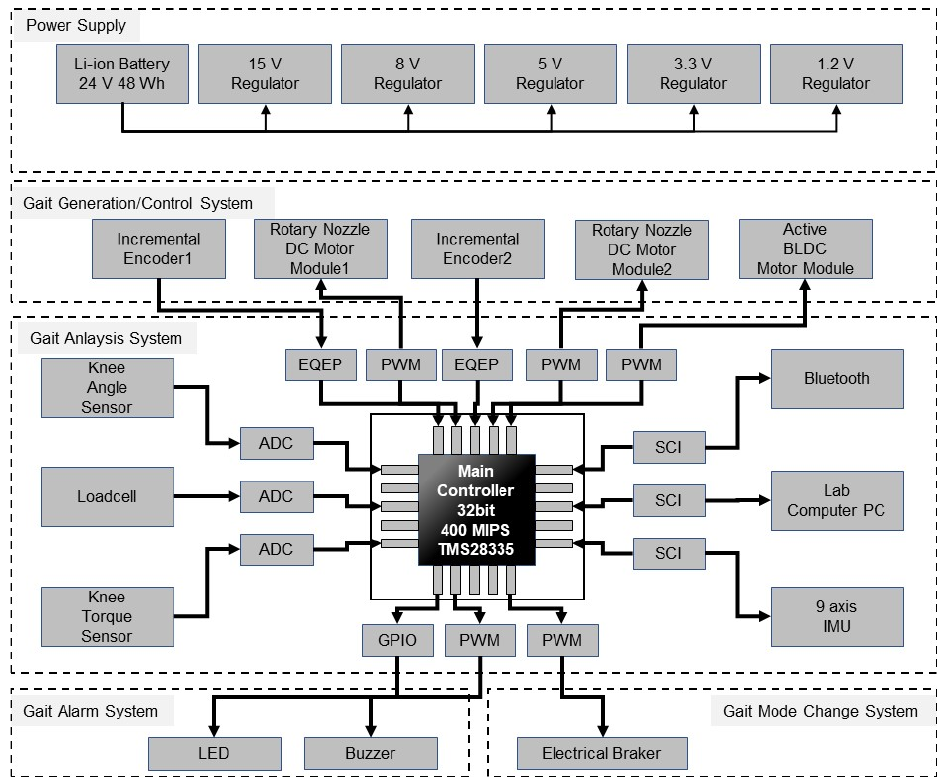
Figure 7. Overview of embedded system architecture.